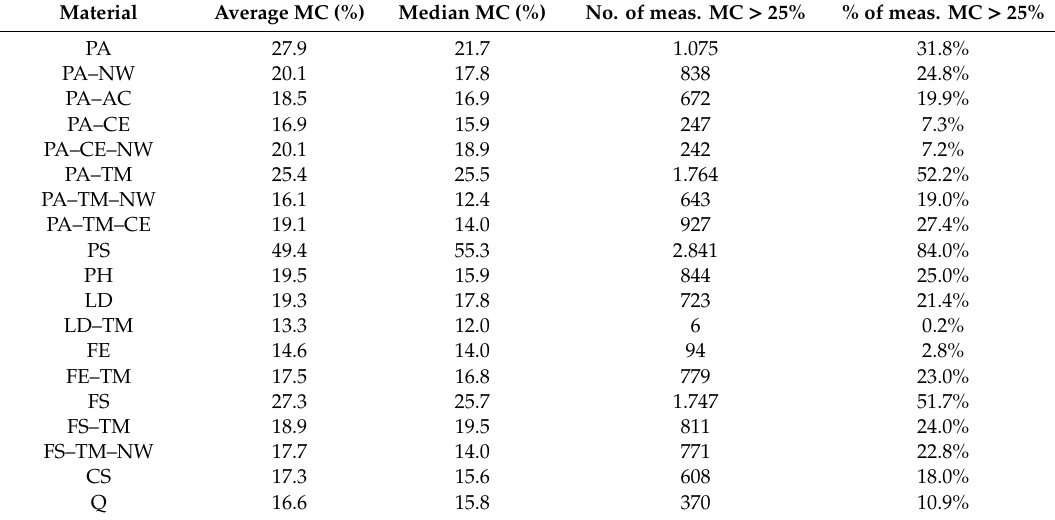
Table 4. Measurements of moisture content (MC) of wood decking at the wooden model house unit. Calculated median and average values of all measurements, and the number and percentages of the measurements with MC equal to or higher than 25% are shown. Measurements were performed in the period between 11.4.2014 and 26.11.2018 ( n =